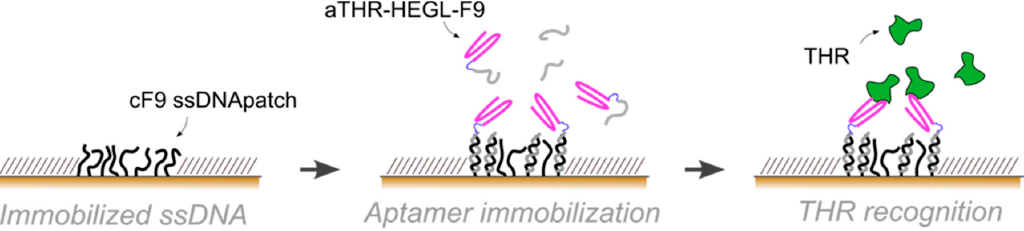
Figure 1. Cartoon representing the DDI strategy to immobilize an aptamer on the micron-sized DNA-based biosensor. DNA-based